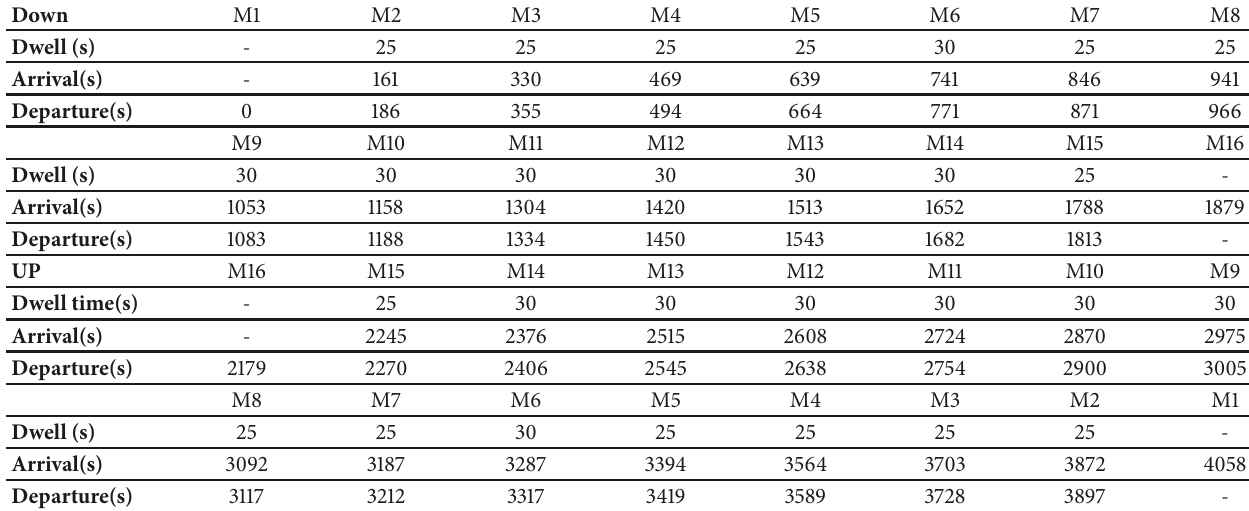
Table 5: The optimized timetable of OTC.